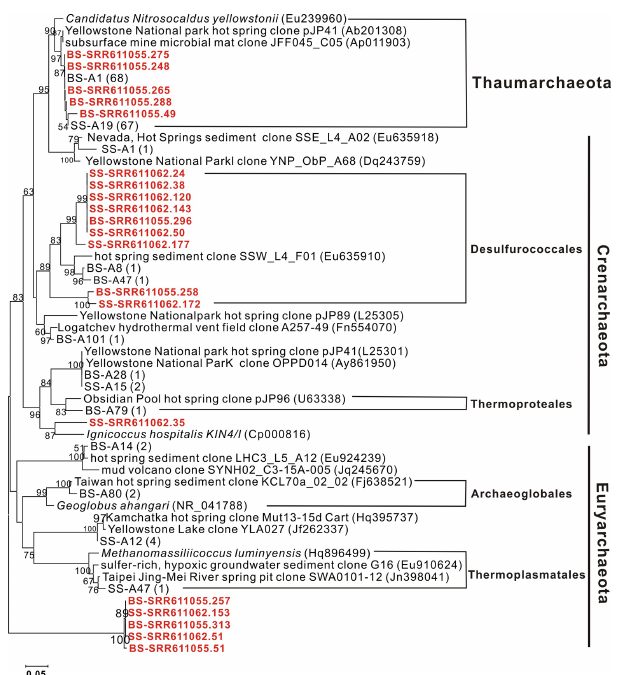
Figure 4. Archaeal phylogenetic tree based on 16S rRNA gene se- quences, including various 16S rRNA gene clones obtained from the Gongxiaoshe hot spring sediments (SS and BS) and cited some sequences from Hou et al. (2013; in red). The tree is constructed us- ing the neighbor-joining method, and bootstrap confidence values over 50% (1000 replicates) are shown. The scale bar represents the expected number of changes per nucleotide position.